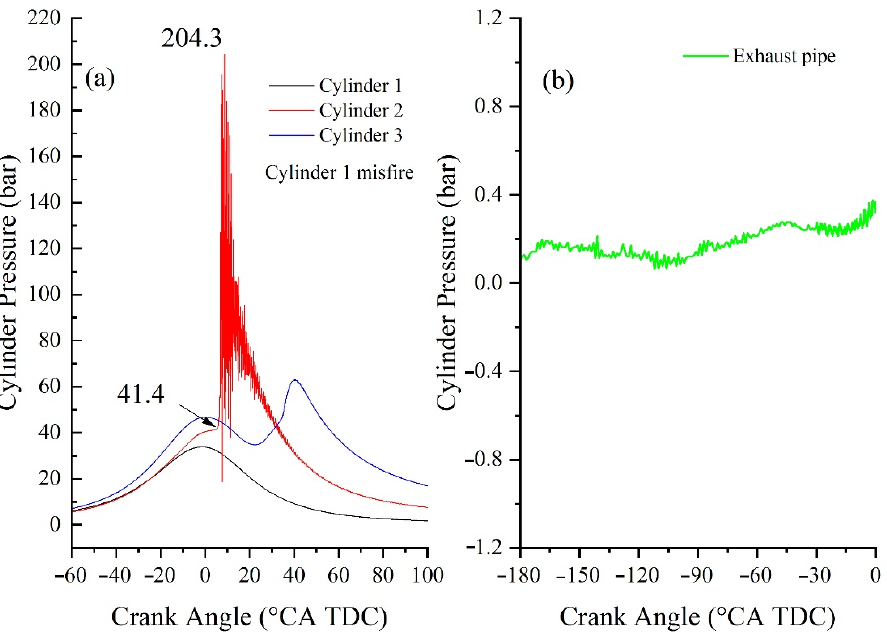
Figure 18. The exhaust pressure and in ‐ cylinder pressure curves with super ‐ knock in cylinder 2: ( a ) the pressure in the exhaust pipe; ( b ) the pressure in cylinders.